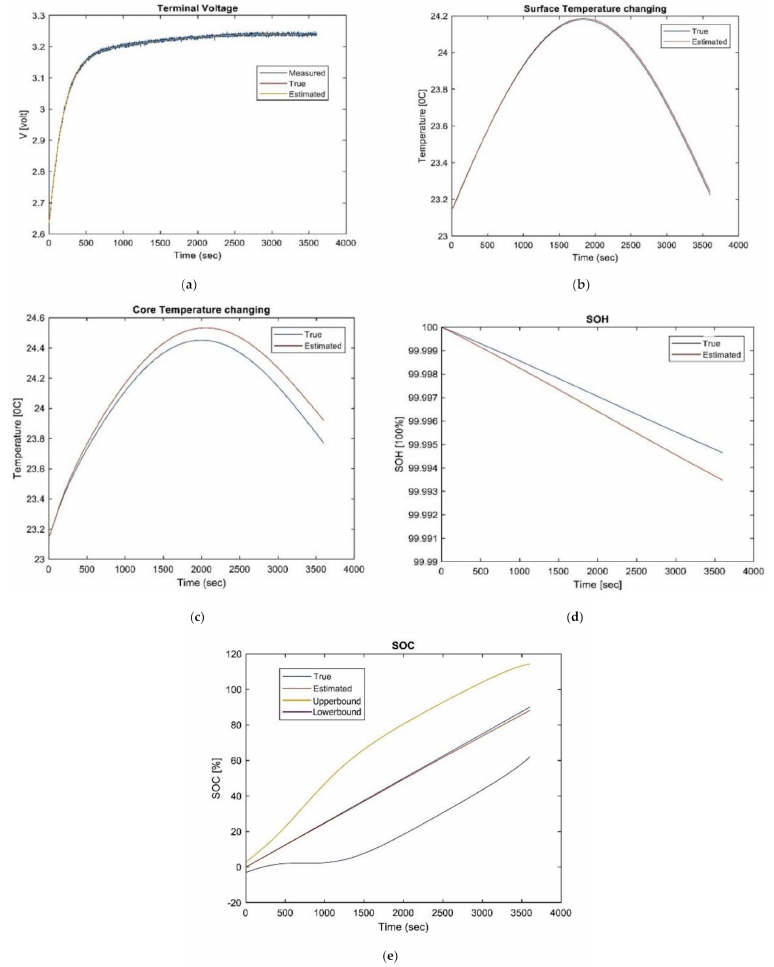
Figure 8. Voltage-measured observer estimation test using wrong parameters; ( a ) terminal voltage, ( b ) service temperature changing, ( c ) core temperature changing, ( d ) SOH, ( e )